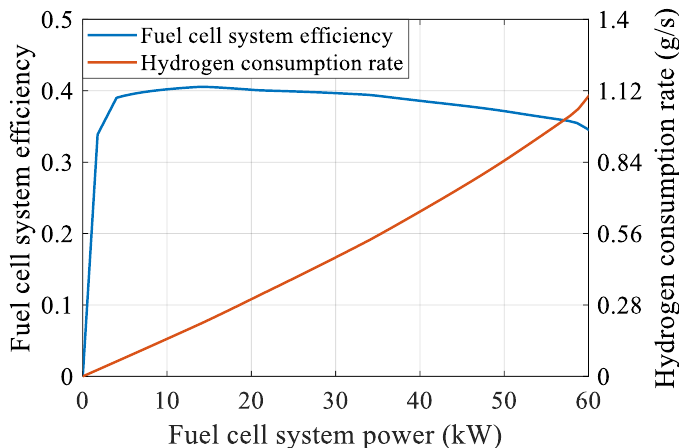
Figure 3. Fuel cell system efficiency and hydrogen consumption